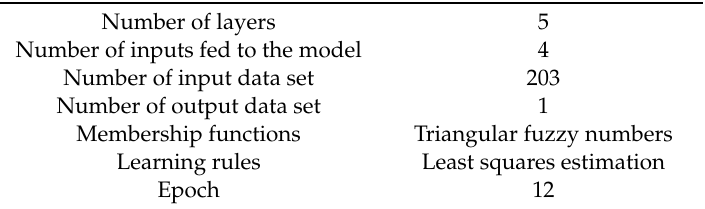
Figure 8. Performance of the Adaptive Neuro-Fuzzy Inference System (ANFIS) model on ( a ) training, and ( b ) test data. Table 9. ANFIS structure and training